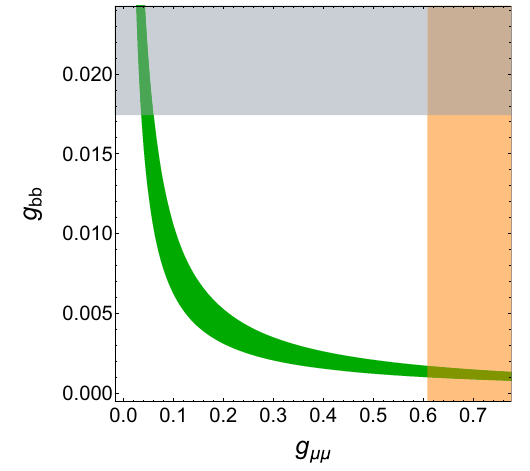
Fig. 1 The parameter space in the ( g μμ , g bb ) plane for M Z (cid:2) = 200 GeV preferred at 68% CL by the b → s (cid:2) + (cid:2) − anomalies (parabolic green band). We also show the regions excluded at 99% CL. by tri- dent neutrino production (vertical orange band), and by the analysis Ref. [53] comparing the (cid:7) m B and B → D ∗ (cid:2)ν probes of the CKM s elements (horizontal grey